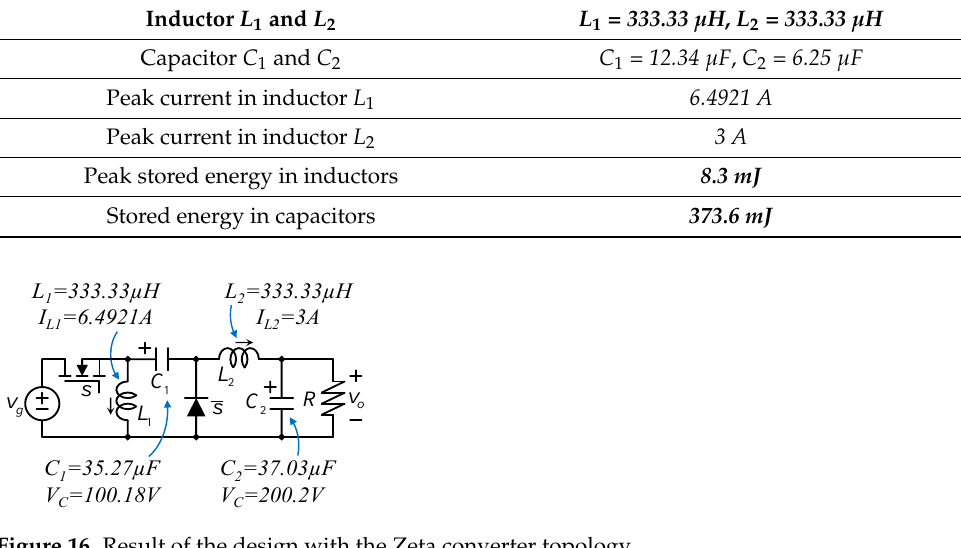
Figure 16. Result of the design with the Zeta converter topology.